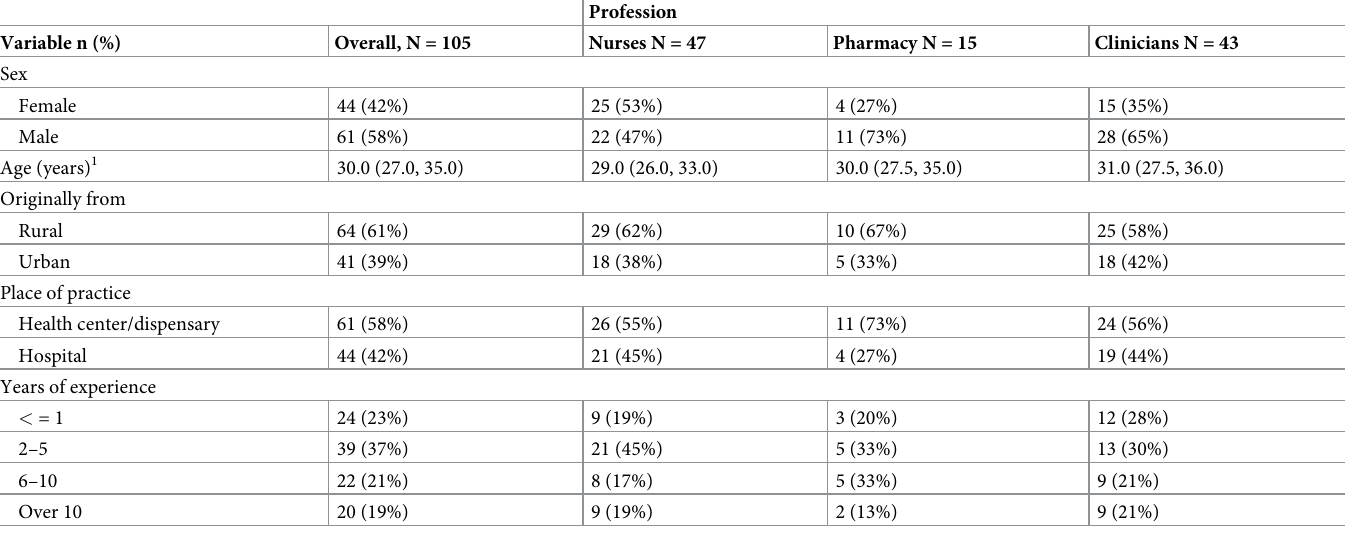
Table 1. Socio-demographic characteristics of study participants in Neno